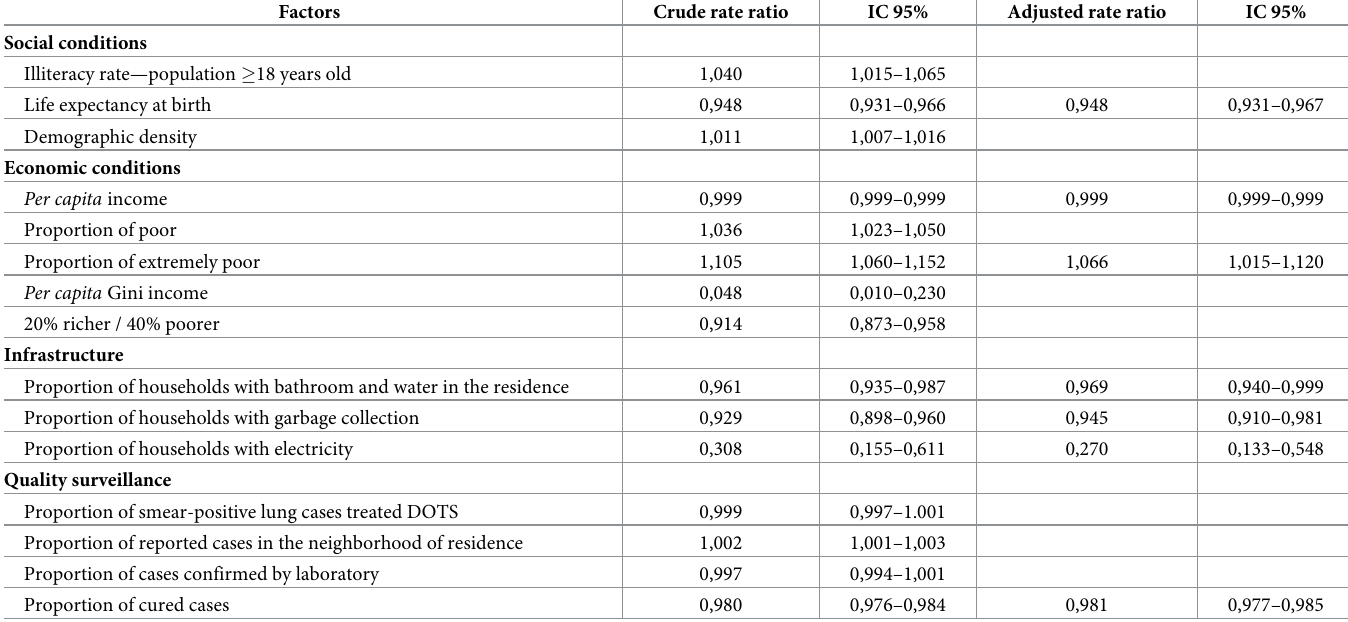
Table 2. Rates of antituberculosis treatment non-adherence by social, economic, infrastructure, and health service quality factors, according to the Poisson regres- sion model. Factors